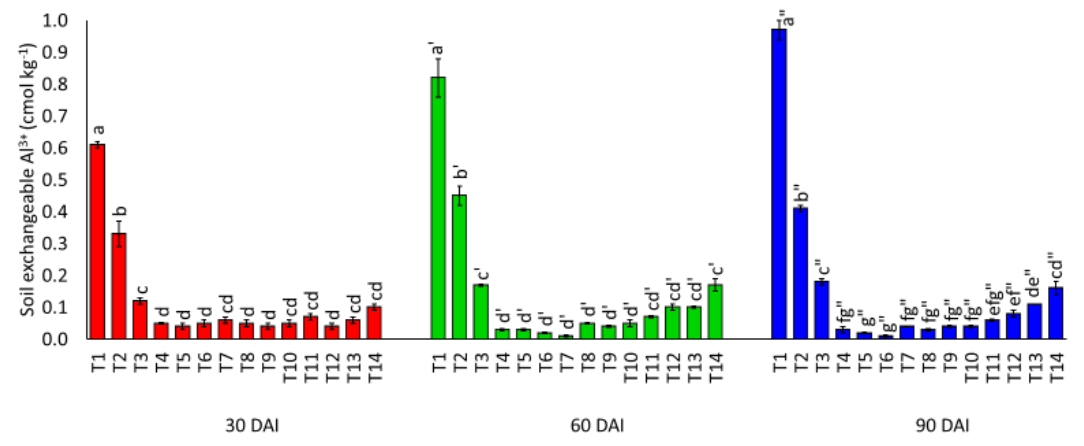
Figure 6. Effects of treatments on soil exchangeable aluminium ions after thirty, sixty, and ninety days of incubation, where T1: soil alone, T2: Egypt rock phosphate alone, T3: Egypt rock phosphate + 100% charcoal, T4: Egypt rock phosphate +